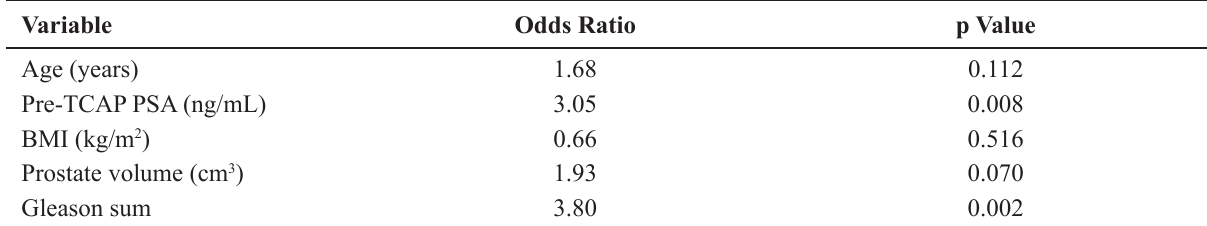
Table 4 – Logistic regression analysis for predicting worsening post- targeted cryoablation of the prostate (TCAP) lower urinary tract symptoms (i.e. increased American Urologic Association Symptom